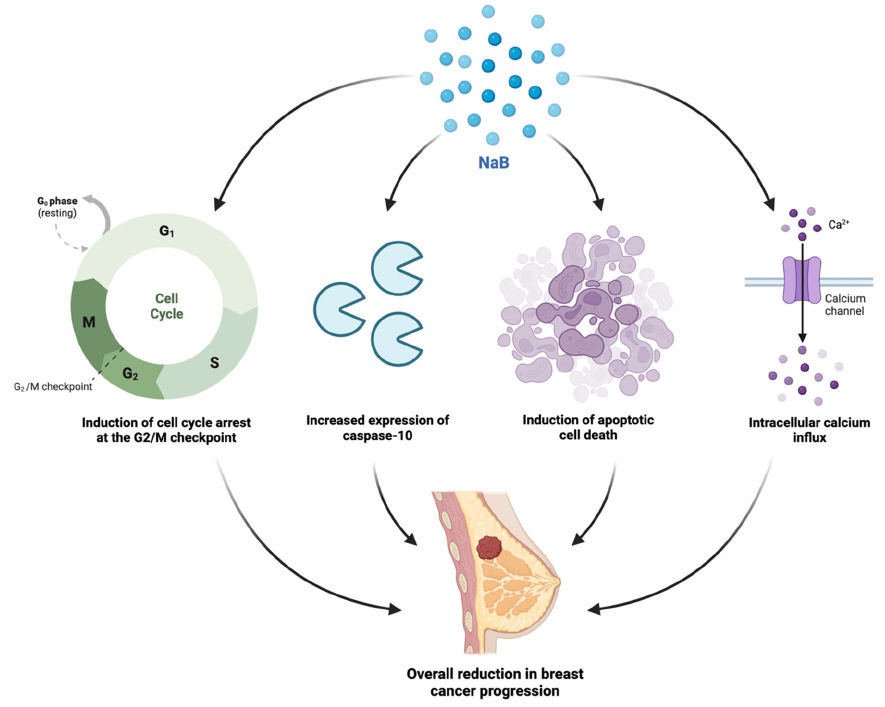
Figure 7. A schematic depiction of the observed in vitro molecular mechanisms of action of the sodium butyrate (NaB) against breast cancer cells including the induction of cell cycle arrest in the G 2 /M checkpoint phase, an increased expression of caspase-10, the induction of apoptosis, and the initiation of intracellular calcium influx [19,25,26,64]. Despite the notable anticancer action of butyrate as a potential stand-alone treatment, it has also been observed to demonstrate a synergistic activity with standard anticancer drugs in recent years (Figure 6). One study assessed the co-administration of NaB with docetaxel against lung cancer cells and identified that the combination therapy synergis- tically inhibited cell proliferation and promoted apoptotic cell death [66]. In specific rela- tion to breast cancer, an earlier study assessed the anti-tumour-enhancing effects of trastuzumab (Herceptin), a recombinant monoclonal antibody, when combined with NaB against a HER2-overexpressing breast cancer cell line [24]. The in vitro study determined that the anticancer effect of NaB was significantly enhanced by the co-administration of trastuzumab, as well as elevated mRNA and protein levels of p27 Kip1 [24]. Similarly, the combinations of retinoids and HDAC inhibitors have been implored as a potential epige- ergistic action of butyrate and vitamin A against the MCF7 breast cancer cells and found bition of 46%, in comparison to the 34% and 10% inhibition observed with butyrate and vitamin A, respectively, as stand-alone treatments [23]. An earlier study acknowledged could serve as a drug carrier for the gut metabolite, and is preferable due to its ability to bind to CD44 on the tumour cell surface, and could improve the anti-proliferative activity of NaB against breast cancer cells, which was further assessed in a recent review [32,67].